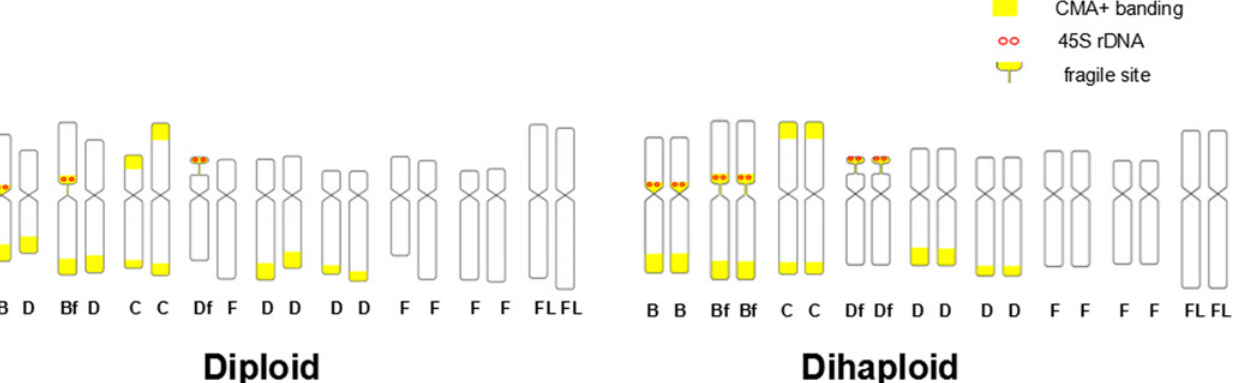
Fig 6. Idiogram of C . sinensis chromosomes with CMA+ bands, 45S rDNA sites and fragile sites. Letters Bf, B, C, Df, D and F indicate chromosome types. Large yellow blocks represent CMA+ bands. Yellow short vertical lines suggest fragile sites and red small circles indicate 45S r DNAs co-localized with CMA+